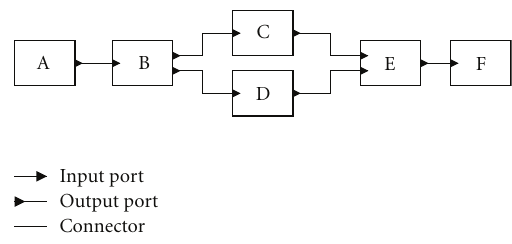
Figure 1: A simple KPN application with application components A, B, C, D, E, and